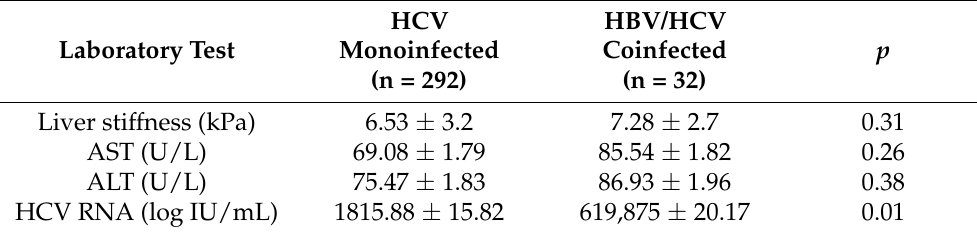
Table 3. Comparison of viral load, elastography, and transaminase levels between HCV-monoinfected and HBV/HCV-coinfected